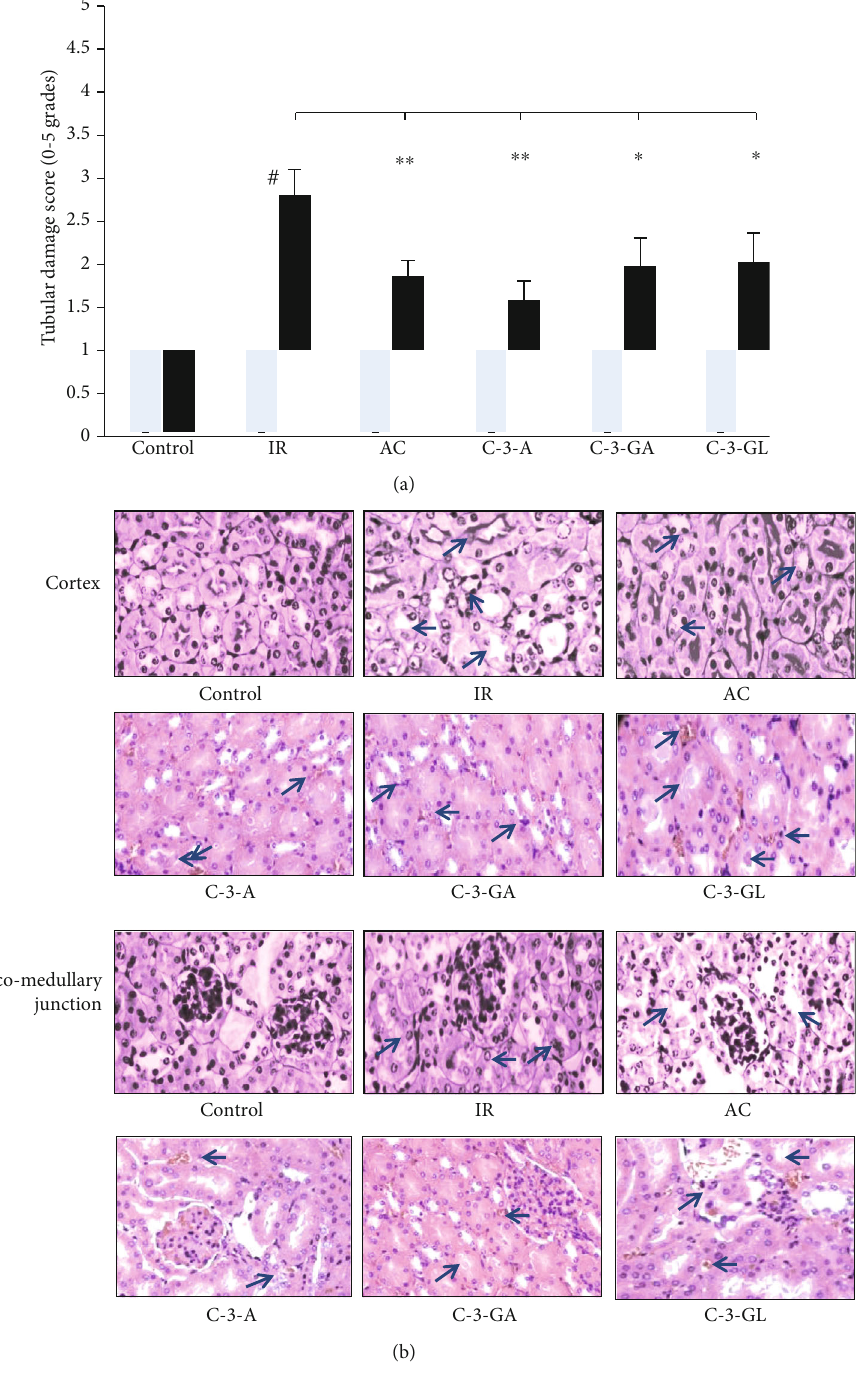
Figure 10: Histopathological evaluation in the renal IR injury and anthocyanin treatment. (a) Quantitative evaluation of renal tubular damage. IR: ischemia/reperfusion; AC: anthocyanins; C-3-A: cyanidin-3-arabinoside; C-3-G: cyanidin-3-glucodise; C-3-GA: cyanidin-3- galactoside. Each group has two scores, one represented before the IR injury (light bars); another represented after the IR injury (black bars). The comparison between treated mice and IR was indicated by asterisks. The data are the means ± SD . n = 7 per group. Histopathological scoring of tubular injury was concomitant with histologic analysis for each experimental group. Data are expressed as mean ± SD . # P < 0 : 01 vs. control; ∗ P < 0 : 05 and ∗∗ P < 0 : 01 vs. IR group. (b) Representative histologic sections of the kidney including cortex and cortico-medullary junction (H&E at × 400). Sham-control group: normal renal tubules with normal cytoplasm and nucleus and no interstitial edema; IR group: the loss of brush border, tubular lumen dilation, vacuolation, and degeneration, shown as blue arrow; AC, C-3-A, C-3-GA, and C-3-GL groups: mild tubular degeneration and edema and trace tubular degeneration, indicated as blue